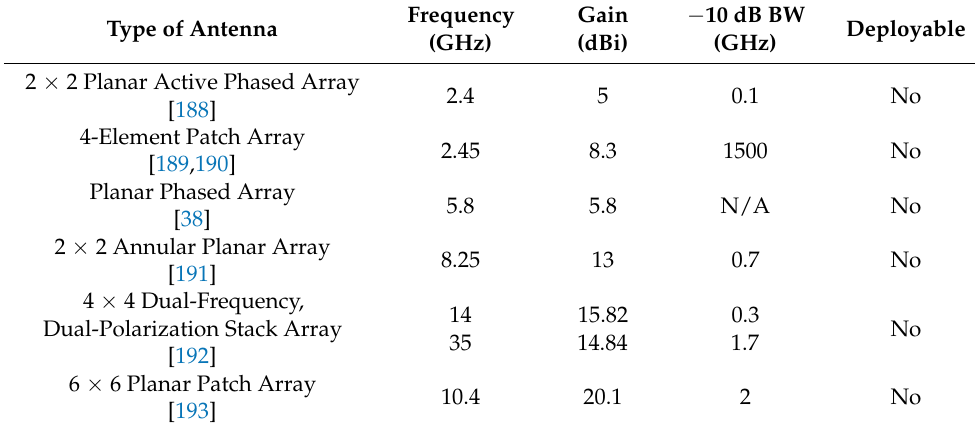
Table 12. Performance of planar antenna arrays. Type of